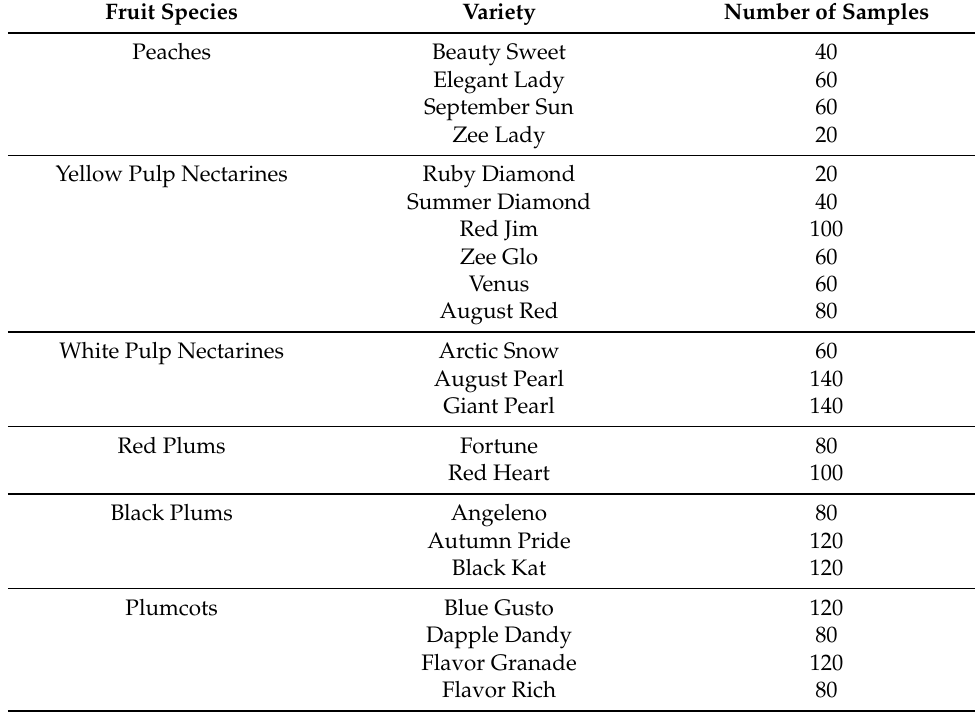
Table 1. Number of samples by species of stone fruits Fruit